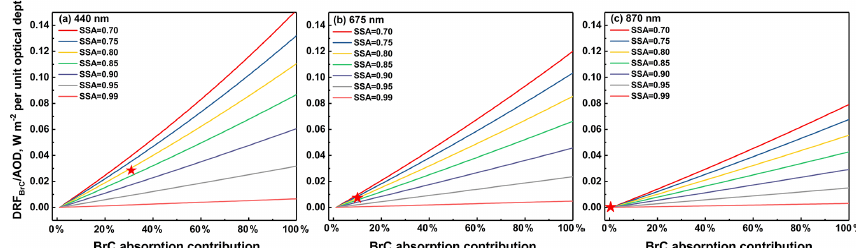
Figure 9. BrC radiative forcing efficiencies, which are defined as the BrC TOA direct radiative forcing divided by the AOD, as a function of the BrC-to-total-aerosol absorption ratio and SSA measured at the surface. The average AOD of the three wavelengths, the average ASY of the three wavelengths, a solar zenith angle of 55 ◦ , and average shortwave broadband surface albedo were used in the calculation. The red star corresponds to the average SSA and BrC absorption contributions determined from this